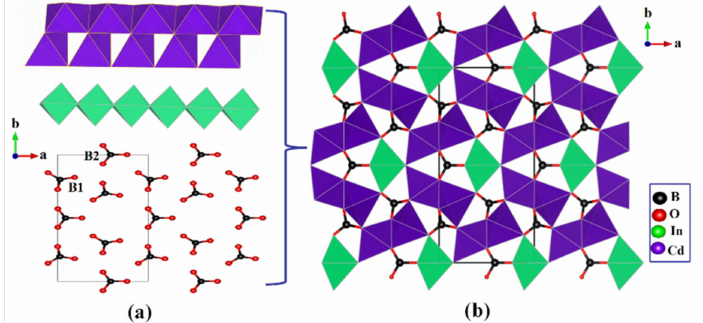
Figure 1. The structure of the CIBO: ( a ) The Cd − O double-chains, In − O single-chain, and the BO 3 units arrangement viewed along the c axis. ( b ) The whole 3D